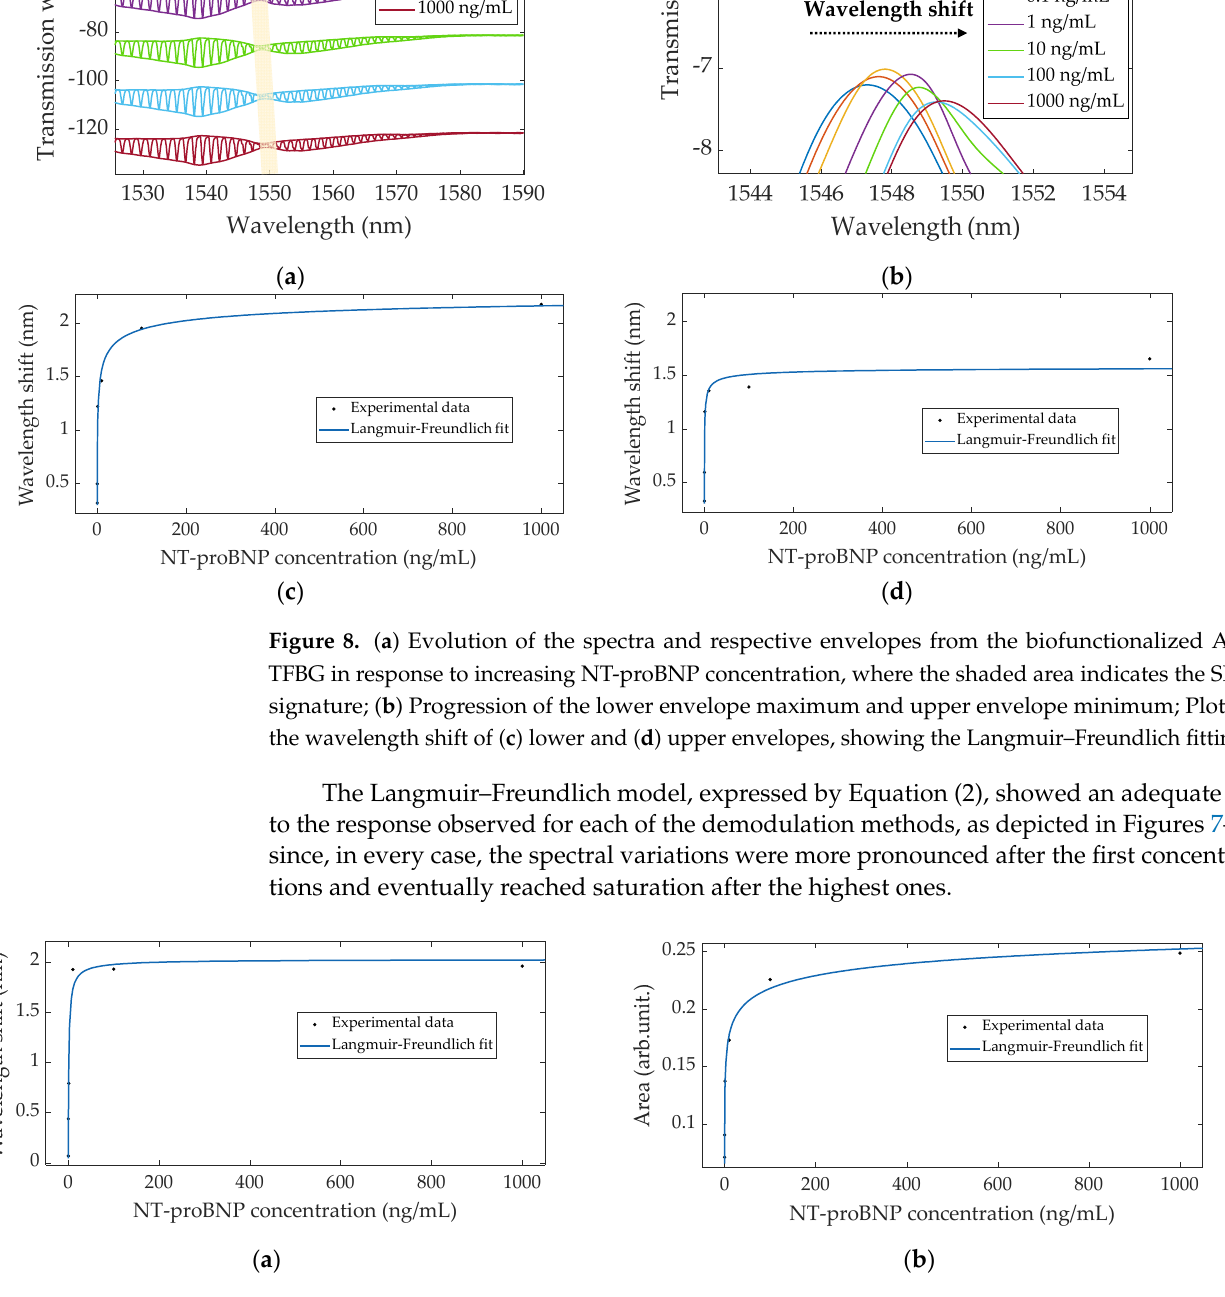
Figure 9. ( a ) Crossing point and ( b ) area variations as a function of NT-proBNP concentration, with the respective Langmuir–Freundlich fittings.